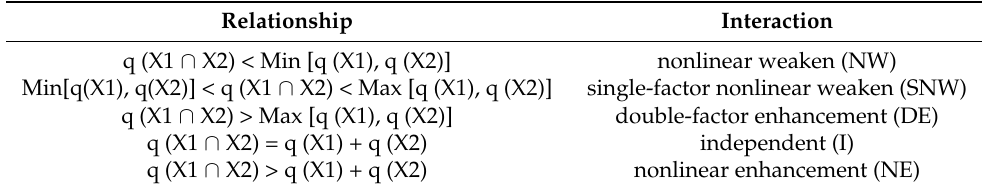
Table 1. Types of interaction between two